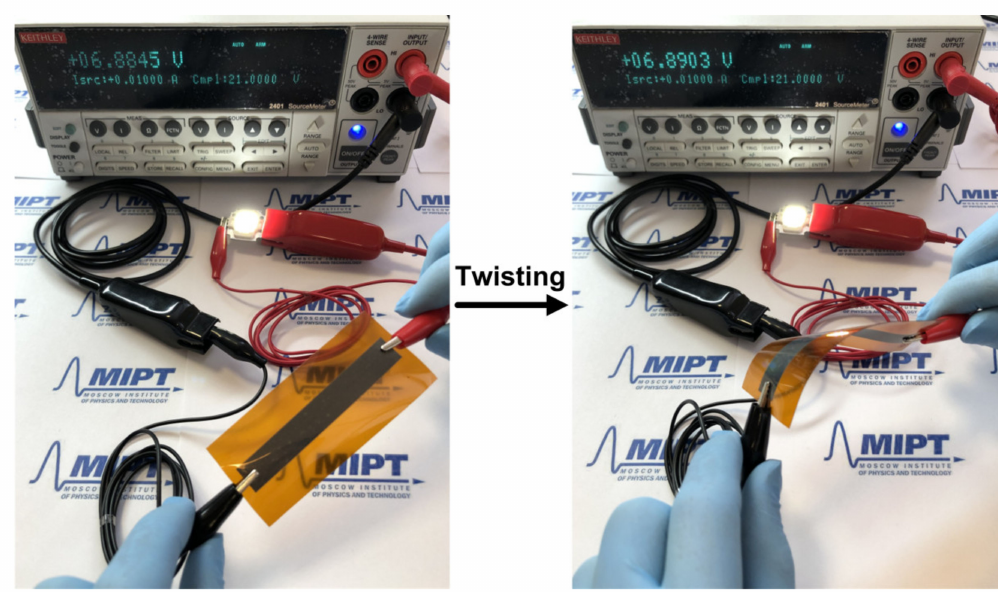
Figure 7. Photographs of the LED circuit with the printed Pt film on flexible polyimide substrate during the twisting